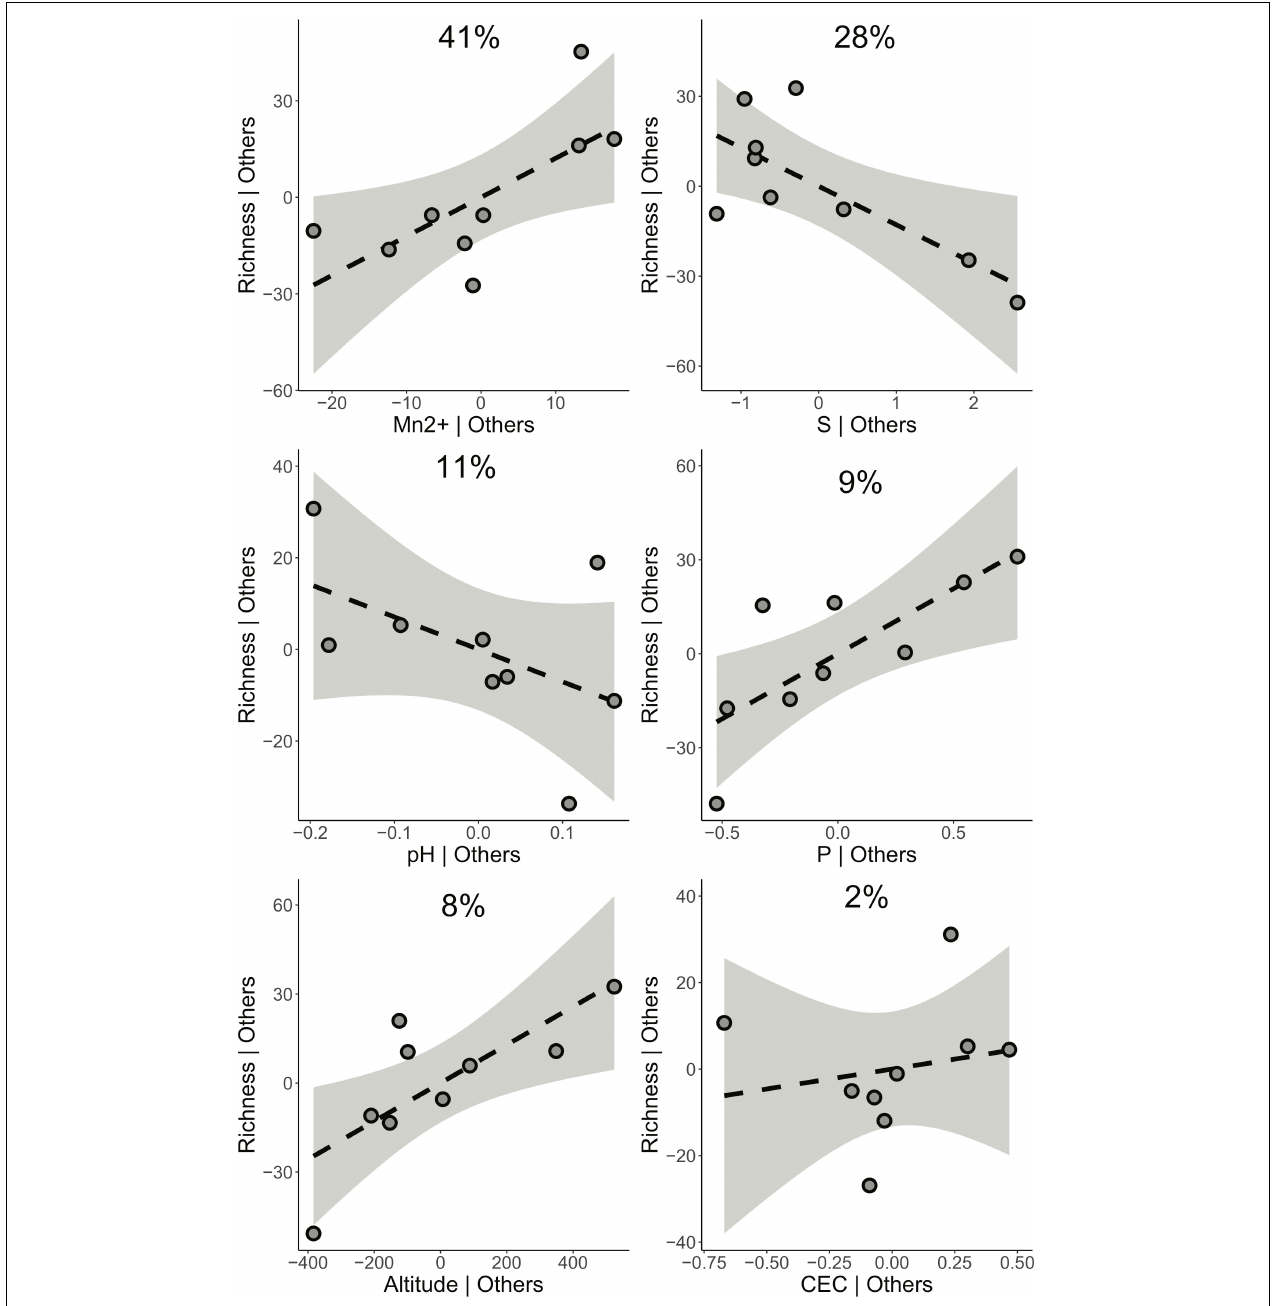
FIGURE 5 | The six environmental constraints that have been considered drivers of richness in the Sumaco Volcano. The scatterplots represent the partial correlation of each environmental constraint on richness, after controlling for the effect of the other five constraints. Percentages at each tile represent the average relative contribution to the R 2 of the constraint in the linear model, after considering all possible linear combinations of entry into the